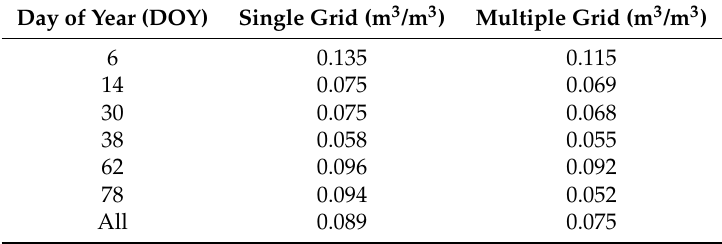
Figure 13. 100 m resolution disaggregated SMAP SM images when using an ISR set to 10 km for single grid ( top ) and moving average window ( bottom ) algorithm for each Landsat overpass date separately. Table 2. Standard deviation of 100 m resolution disaggregated SM within each DISPATCH Exp image for the single grid and multiple grid